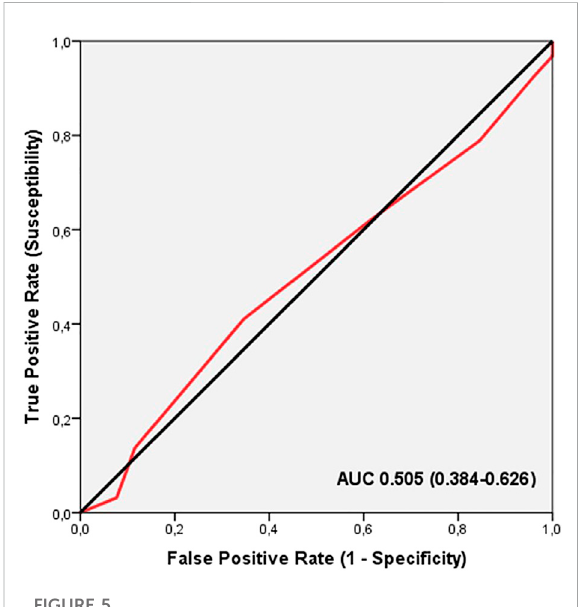
FIGURE 5 Receiver operating characteristic curve (ROC) summarizing theabilityofthetotalgenotypescore(TGS)todistinguishpotential non-severely injured players from severely injured players in muscle performance pro fi le, AUC, area under the curve.